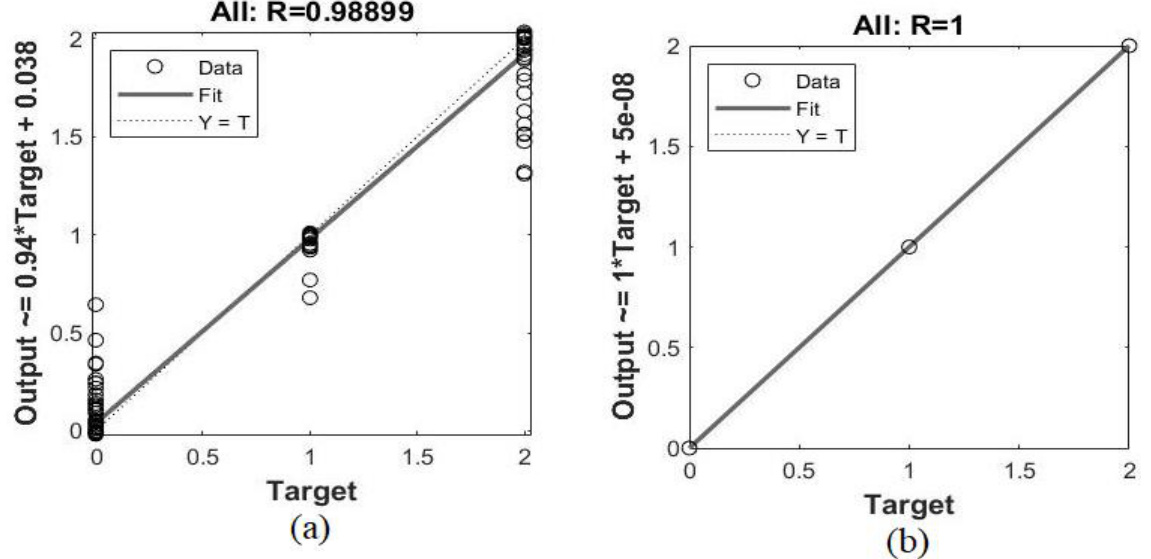
Figure 17. Regression of the ( a ) ALL_IDB1 and ( b ) ALL_IDB2 datasets.